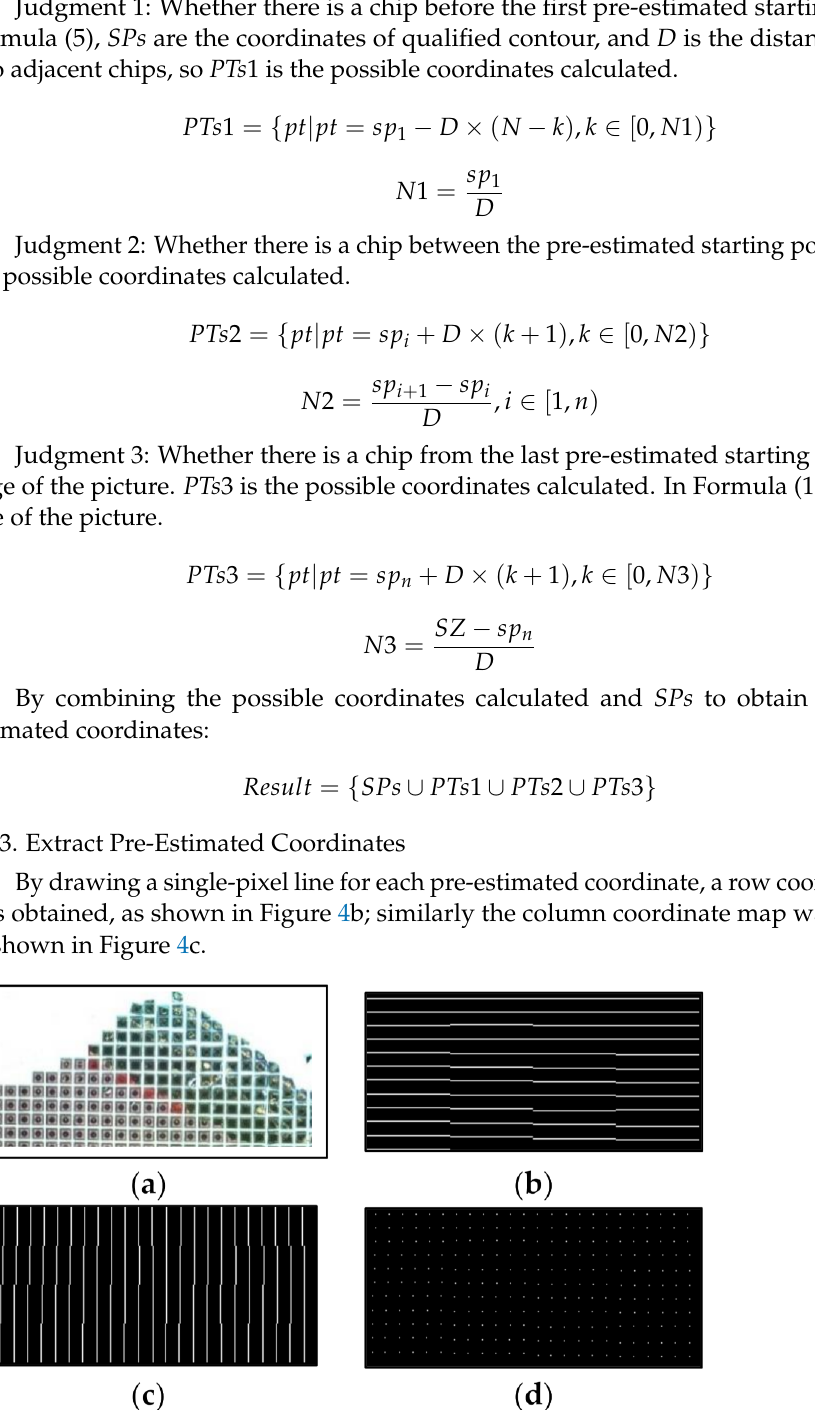
Figure 4. Results in the process of pre-estimating position: ( a ) original picture; ( b ) row coordinate map; ( c ) column coordinate map; ( d ) pre-estimated point